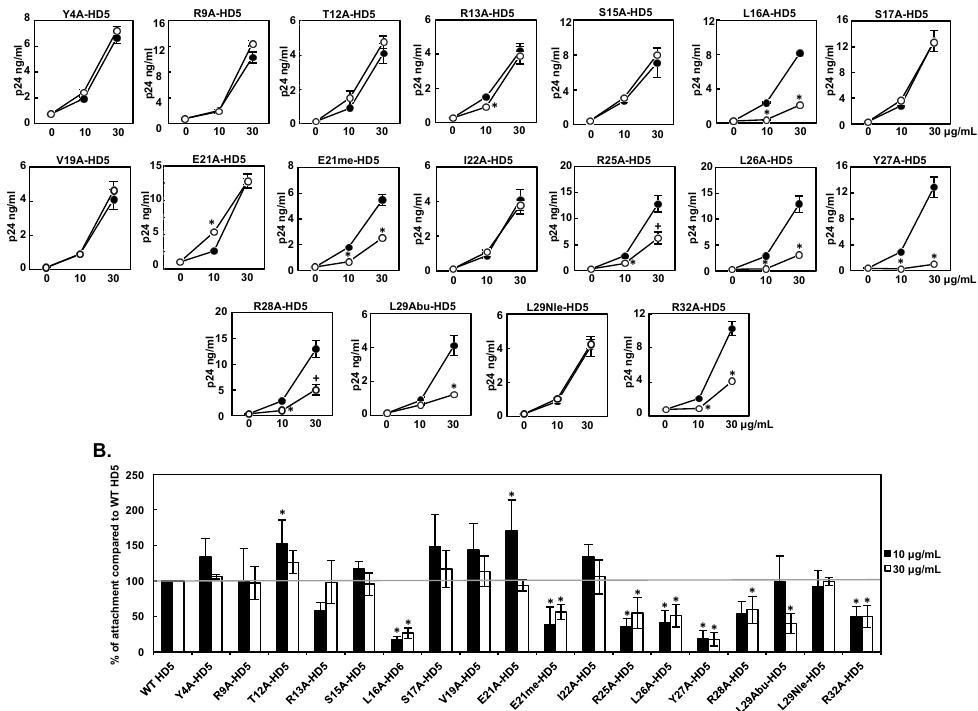
Figure 2. Effect of HD5 mutants on HIV attachment-enhancing activity. HD5 mutants were incubated with serum-free HIV-1 JR-FL for 1 h, and then the defensin–virus mixture was added to HeLa-CD4-CCR5 cells at 4 °C for 1 h. After washing off unbound viruses, cell-associated p24 was measured. ( A ) Results of a representative independent experiment for WT HD5 (filled circles) and each HD5 mutant (open circles) are shown. The baseline of cell-associated HIV p24 of control samples without defensin treatment was 130–779 ng/mL. Data are means ± SD of triplicate samples. * p < 0.05, WT HD5 versus HD5 mutants at the same concentration; 2-tailed Student’s t -test. After Bonferroni correction, the difference between WT HD5 versus R25A-HD5 and R28A-HD5 at 30 μ g/mL was not significant (+ p > 0.05); ( B ) Data represent the average relative percent of each HD5 mutant on HIV attachment compared to WT HD5 at the same concentration from seven independent experiments. * p < 0.05, WT HD5 versus HD5 mutants at the same concentration; one-way ANOVA with Bonferroni post-test.